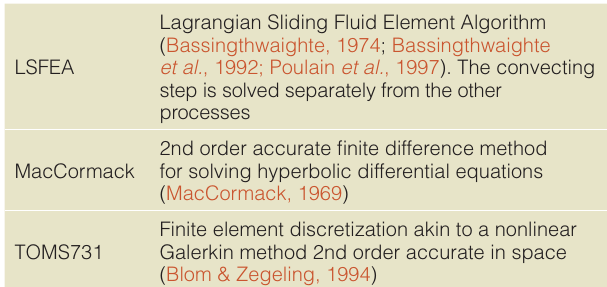
Table 2. JSim PDE